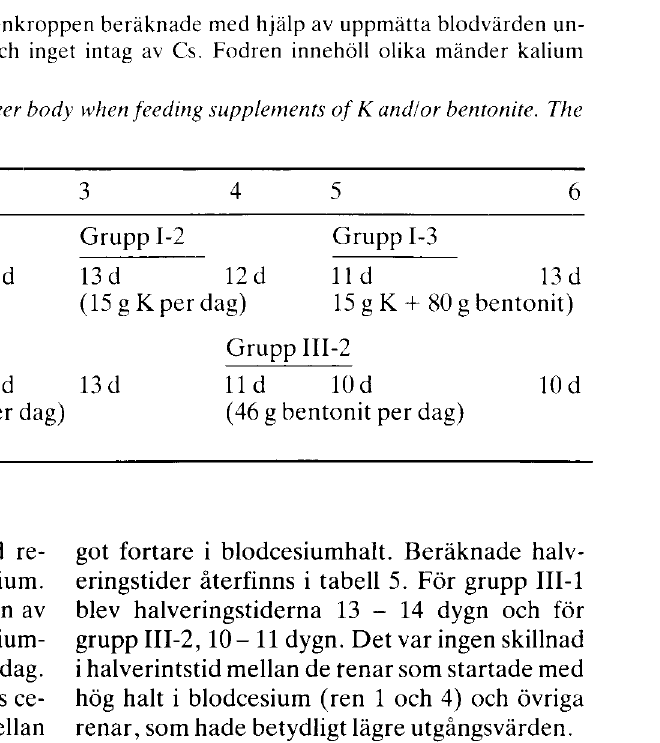
Table 5. Half times f or radiocesium in the reindeer body when feeding supplements of K andi or bentonite. The animals had no intake of